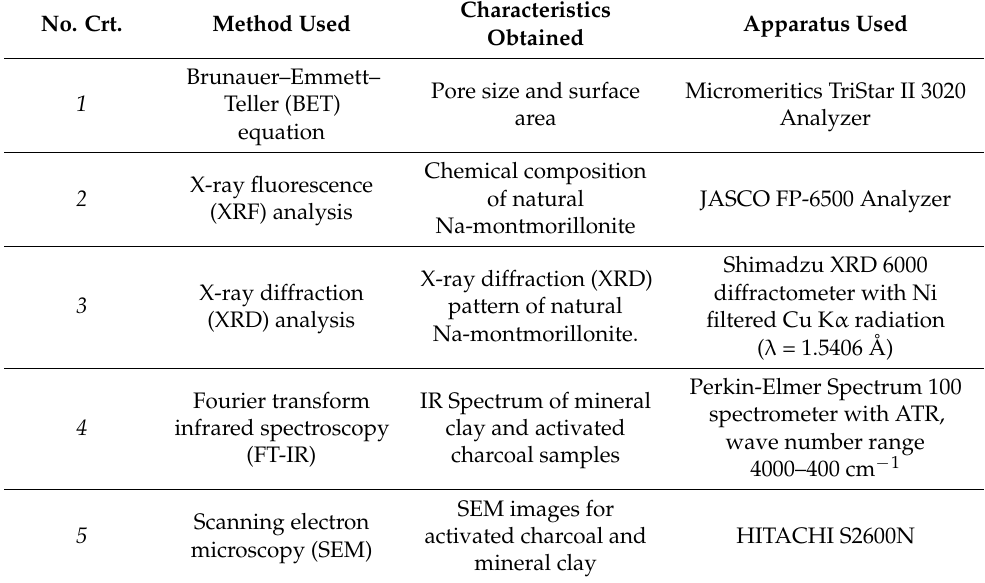
Table 2. Methods to characterization of